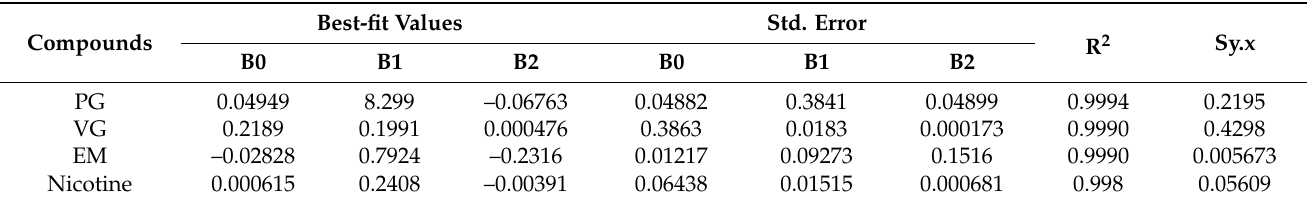
Table 1. The best-fit values B0, B1, and B2, the standard errors associated with the coefficients, the correlation coefficient (R 2 ), and the standard error of the estimate (Sy.x) of the quadratic models for PG, VG, EM, and nicotine.